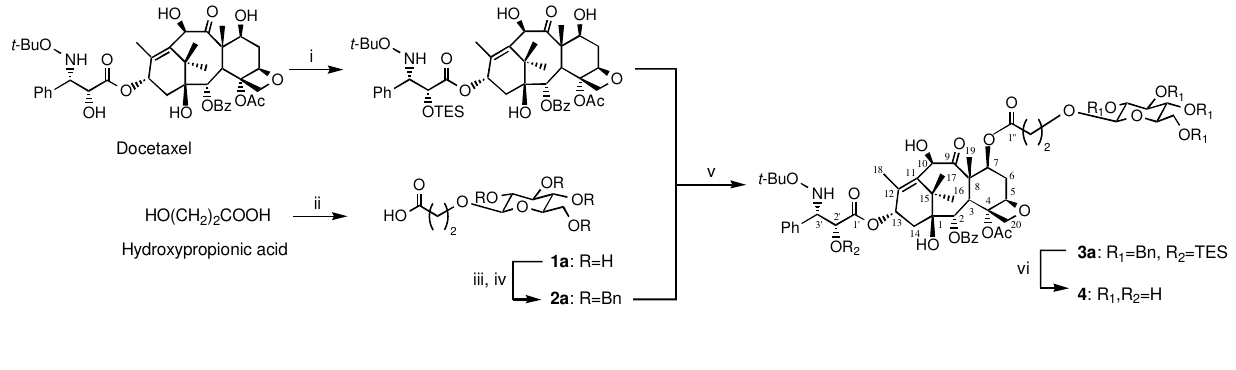
Figure 1. Synthesis of the docetaxel prodrug 7-propionyldocetaxel 3''- O - β - D -gluco- pyranoside ( 4